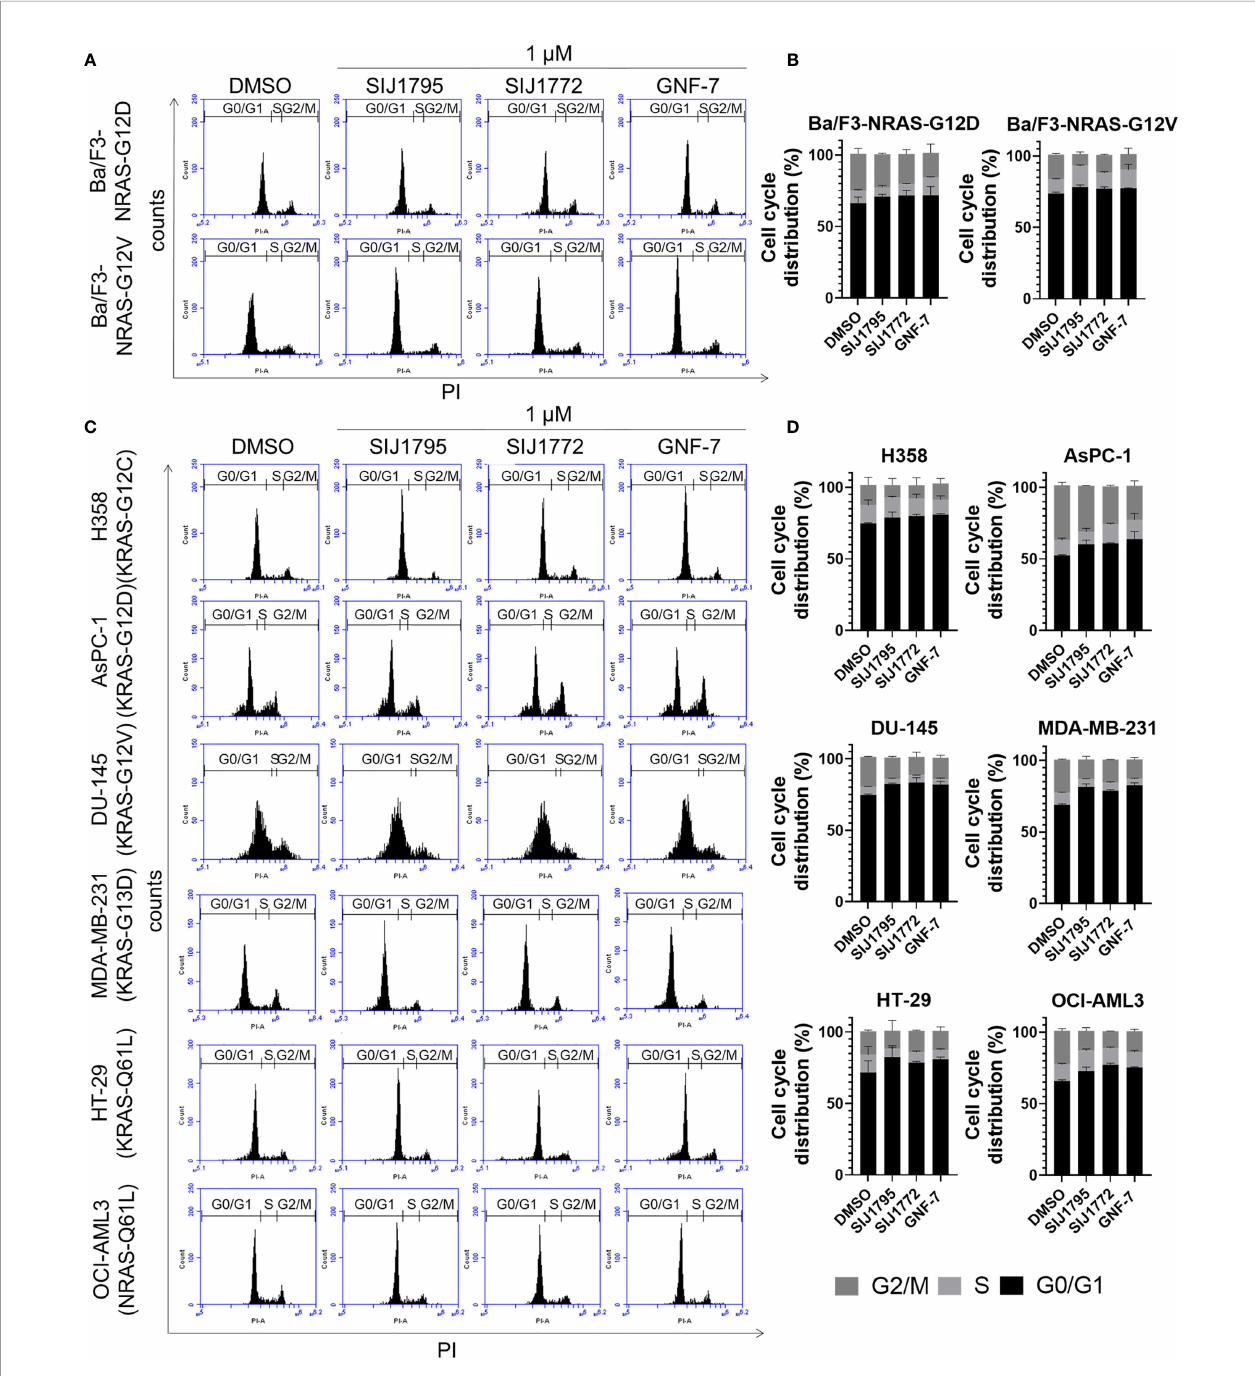
FIGURE 5 | The effects of SIJ1795 and SIJ1772 on cell cycle arrest against in (A, B) Ba/F3 cells transformed with mtRAS (NRAS-G12D and NRAS-G12V) and (C, D) cancer cells harboring mtRAS. Cells were treated with 1 µM of SIJ1795, SIJ1772, and GNF-7 for 24 h. Cells were stained by PI and analyzed the percentage of cell cycle phase by fl ow